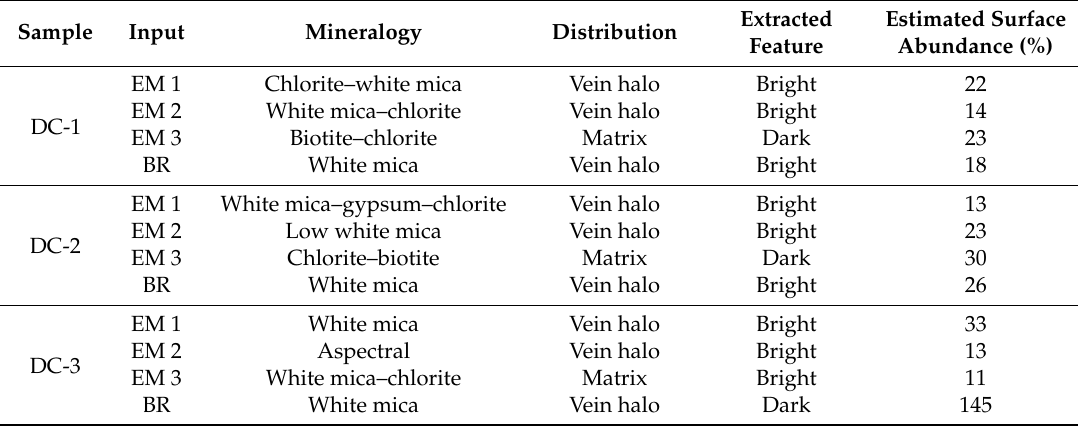
Table 3. Summary of vein extraction results (EM = endmember, BR = band ratio). The estimated density is represented by the surface percent covered by a particular vein type extracted from the input image; for the extracted features, bright indicates high abundance, while dark indicates low